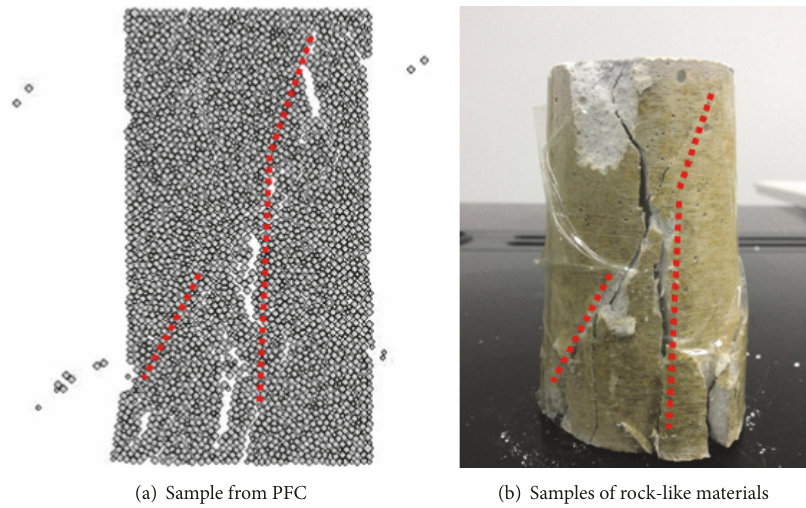
Figure 3: Failure patterns in the cylindrical sample subjected to uniaxial